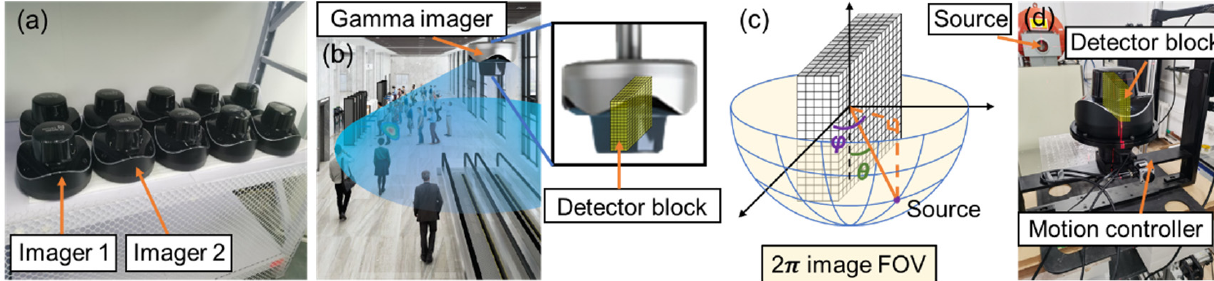
Figure 3. ( a ) Picture of several gamma imagers. ( b ) Illustration of radiation source monitoring scenario. ( c ) Illustration of system matrix calibration setup. ( d ) Picture of realistic system matrix calibration process.